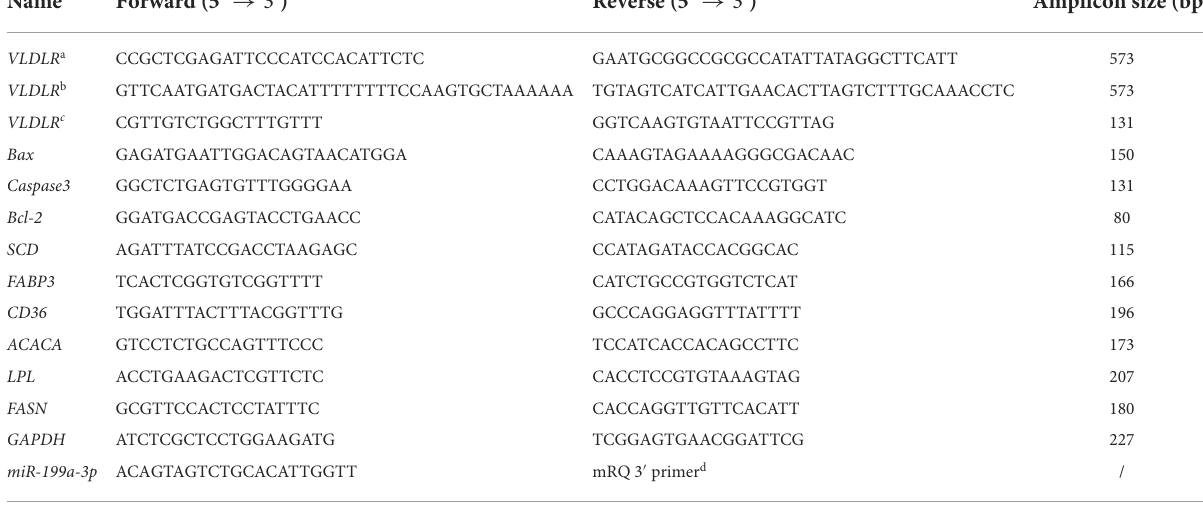
TABLE 1 PCR primers used in the study.